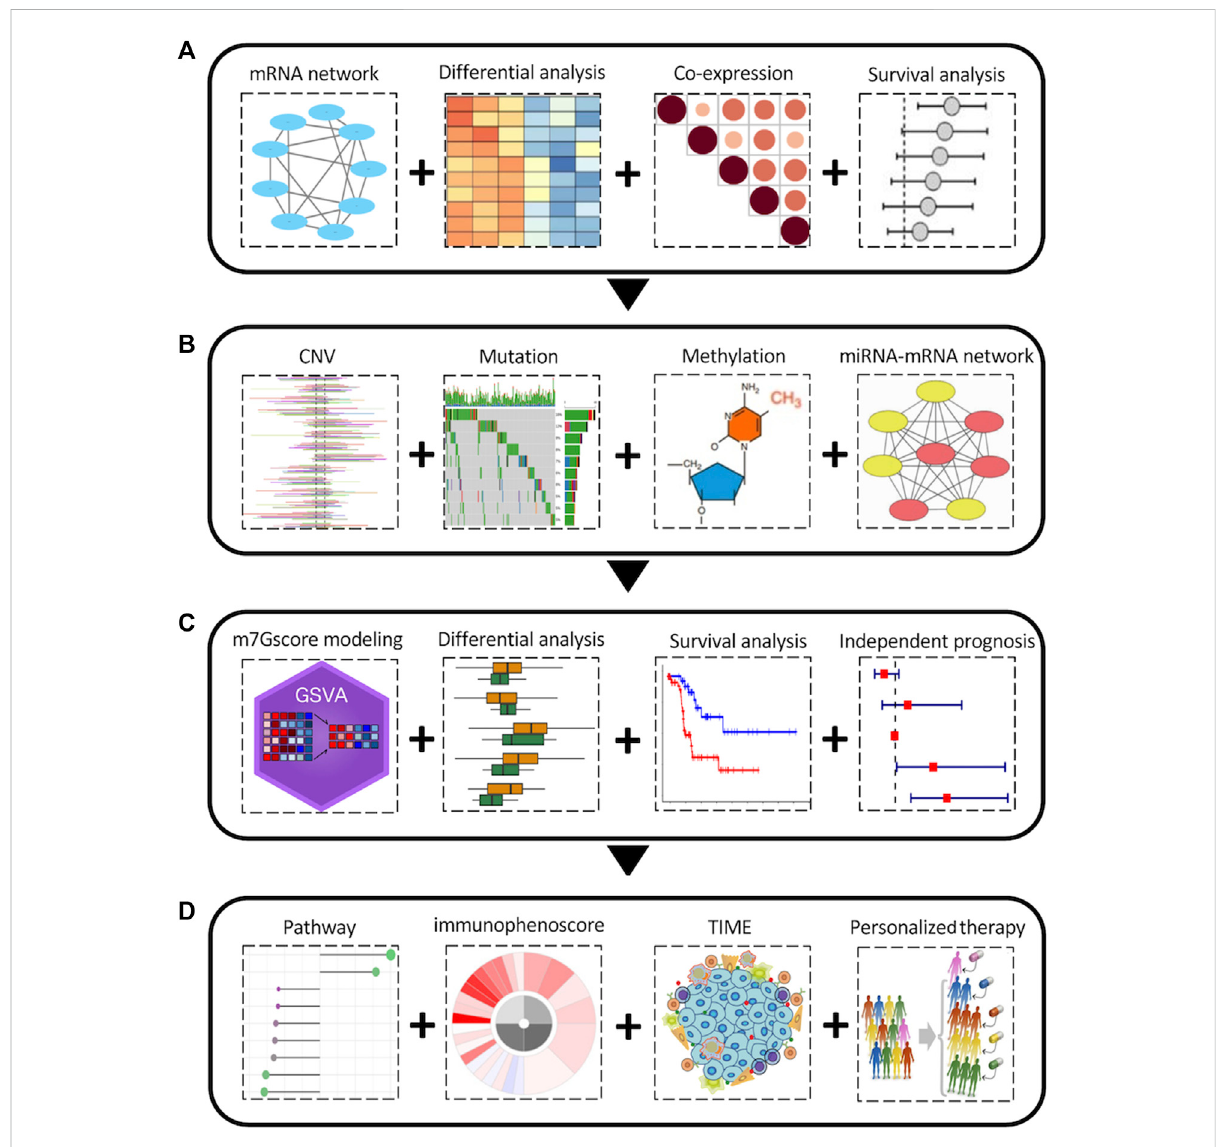
FIGURE 1 The overall pan-cancer analysis work fl ow of the m7G regulators. (A) Aberrant expression and clinical relevance of m7G regulators across cancers. (B) The genetic variations and epigenetic regulation of m7G regulators across cancers. (C) m7Gscore modeling and its clinical relevance among cancers. (D) Relationship between m7Gscore and associated pathways, immunophenotypes, tumor immune microenvironment, immune therapy and chemotherapy sensitivity among